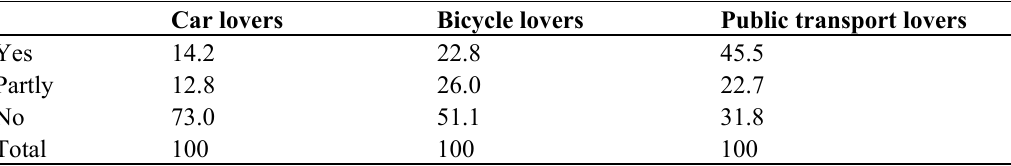
Table 2. Relationship between preferences for modes and the responses given (%) on choice for neighbourhood as related to preference Car lovers Bicycle lovers Public transport lovers Yes 14.2 22.8 45.5 Partly 12.8 26.0 22.7 No 73.0 51.1 31.8 Total 100 100